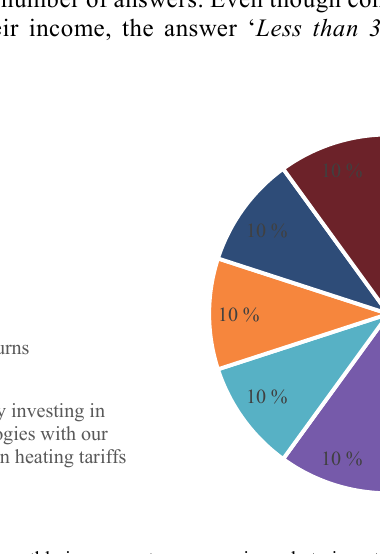
Fig. 12. Part of monthly income entrepreneurs is ready to invest in green